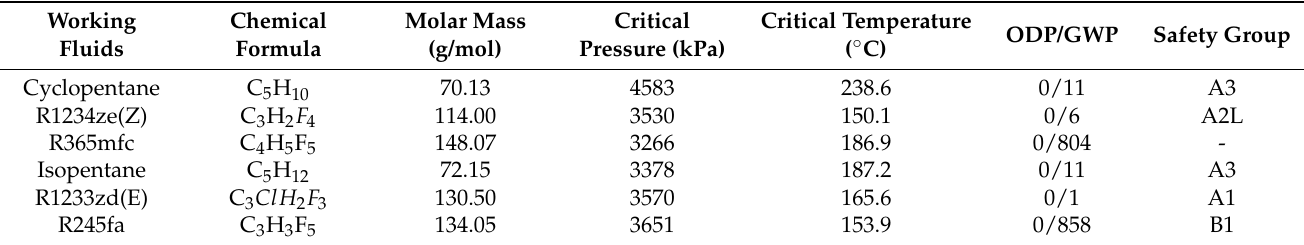
Table 2. Properties of six working fluids selected for the ROFC